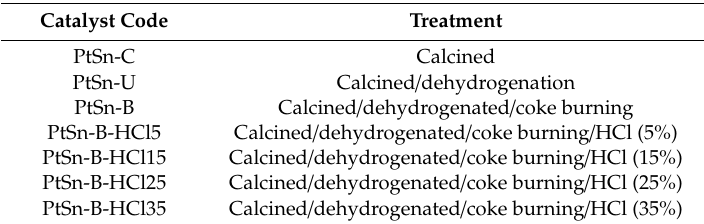
Table 1. Procedure for catalyst regeneration (dehydrogenated: first reduction + propane dehydrogenation (PDH) reaction).